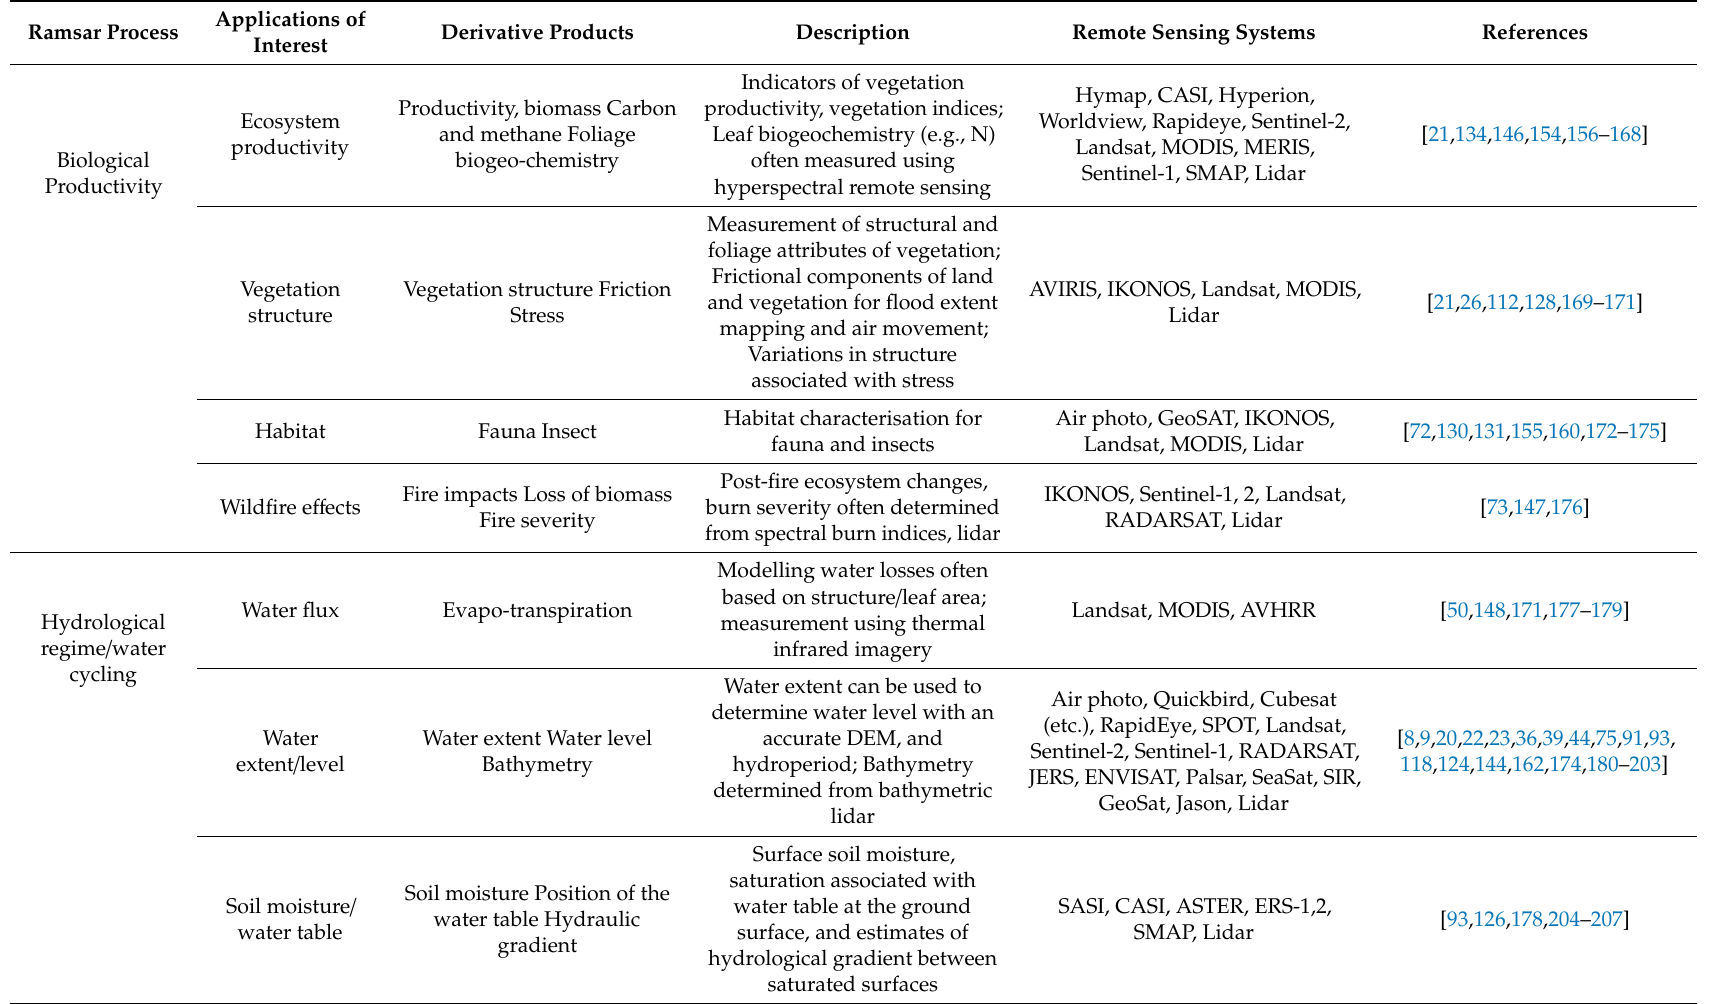
Soil moisture Position of the water table Hydraulic gradient